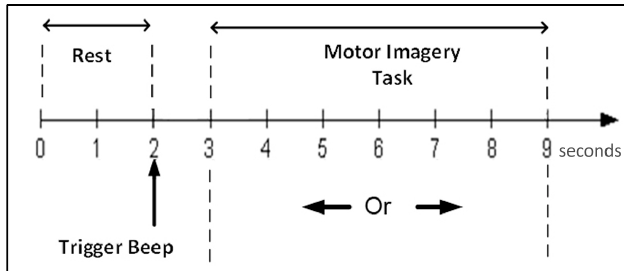
Figure 1. Graz dataset experience paradigm.